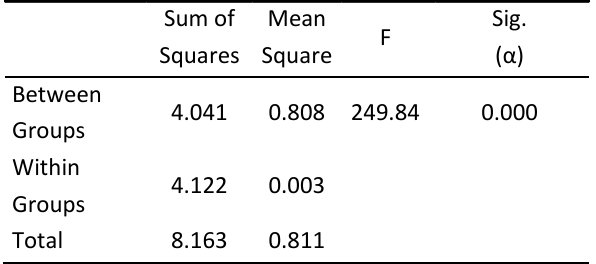
Table 3: The results of ANOVA analysis for trunk deformation growth rate of742 palm trees in all locations. Sum of